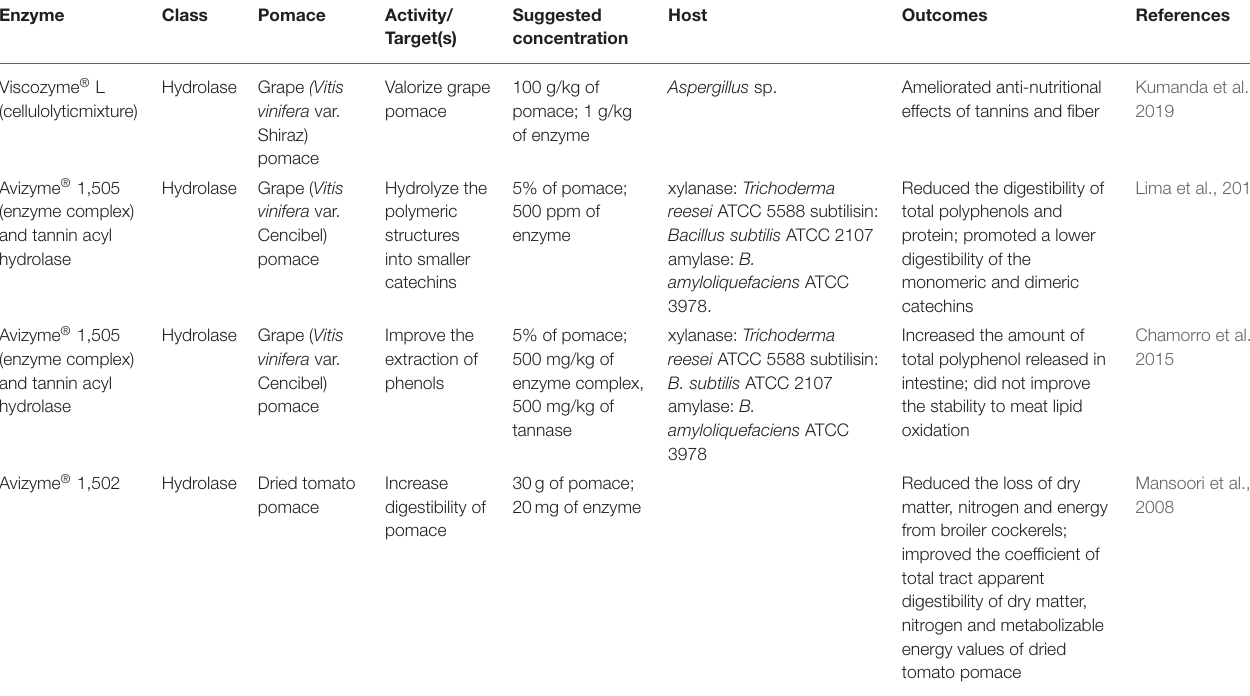
TABLE 2 | Examples of exogenous enzymes used to enhance fruit s pomaces’ quality as animal feed additives. Enzyme